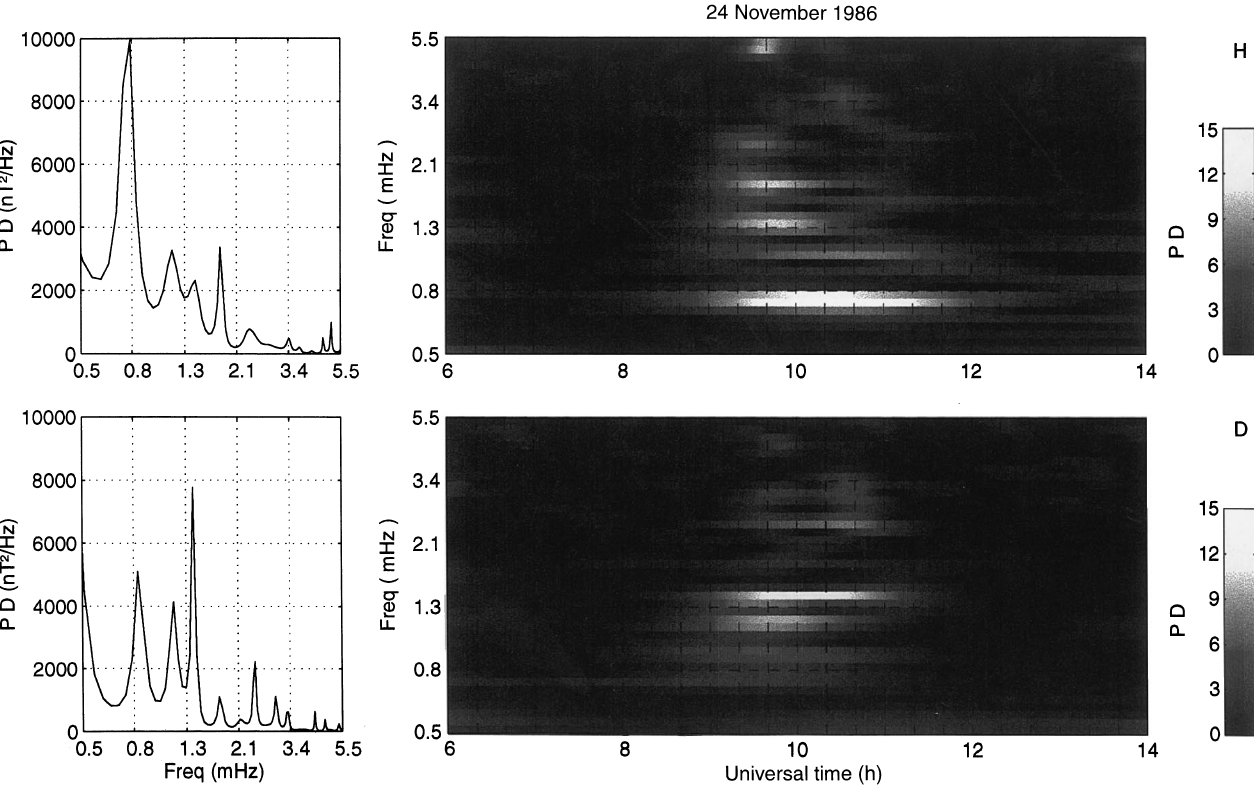
Fig. 2. The average power spectra computed by means of the maximum entropy method in the time interval 0900–1200 UT are plotted on the left for the H ( upper panel ) and D ( lower panel ) components. The dynamic power spectra of the two components are shown on the right for the longer time interval 0600–1400 UT; here the power is in